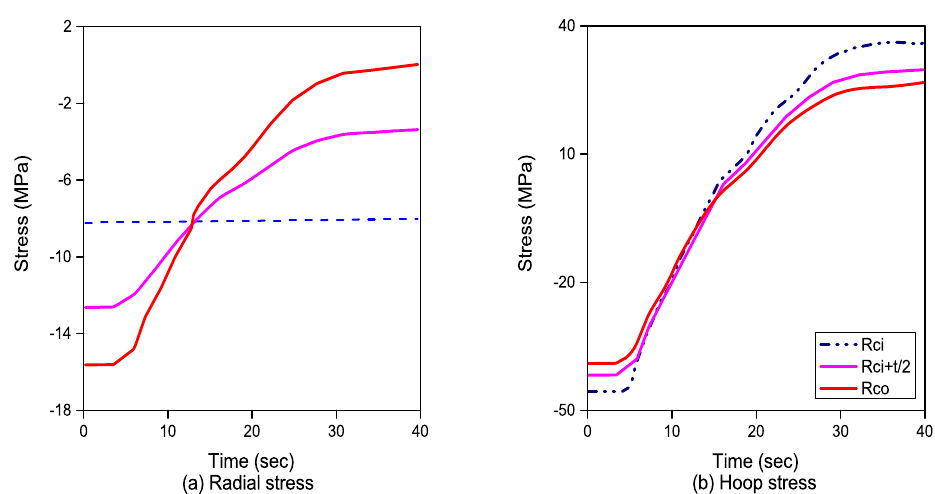
Figure 6. Pressure-induced stress distributions.